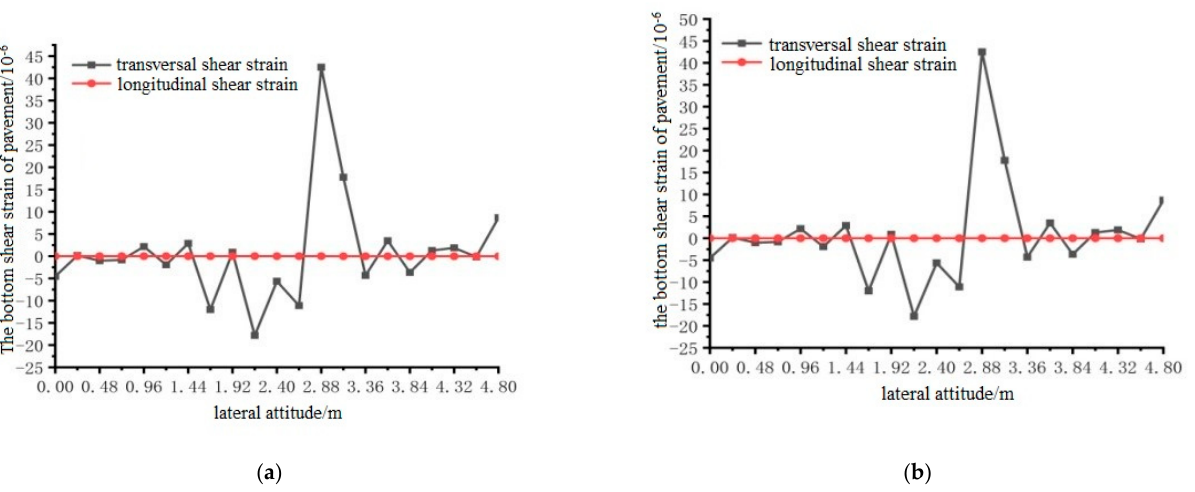
Figure 34. The transverse distribution of longitudinal and transverse shear strain on the surface of the pavement with and without temperature field under the action of load level 2. ( a ) Longitudinal and transverse shear strain diagrams without temperature field effect; ( b ) Longitudinal and transverse shear strain diagrams with temperature field effect.